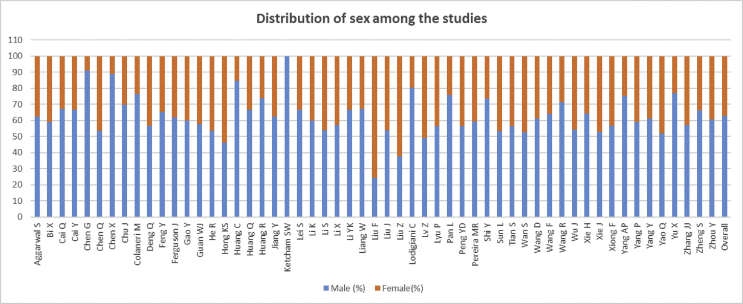
Distribution of sex of included studies to analyze the effect of sex on for the severity of COVID-19.